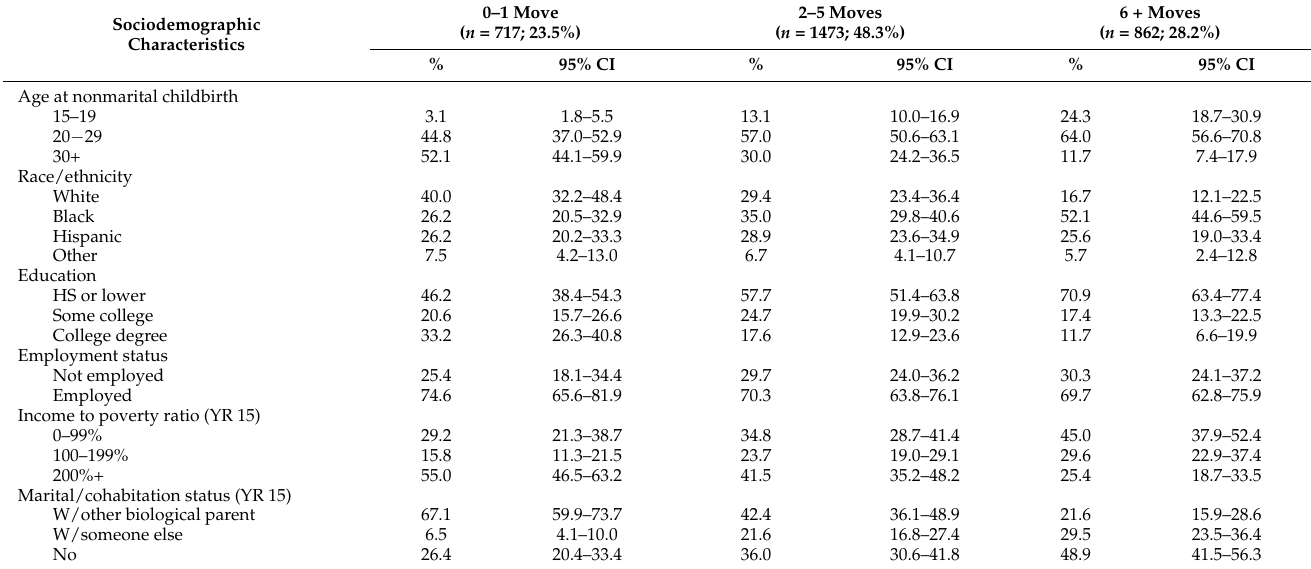
Table A1. Socioeconomic characteristics among US mothers by cumulative residential moves from Year 1 to Year 15 following a childbirth, Fragile Families and Child Wellbeing Study ( n = 3052).